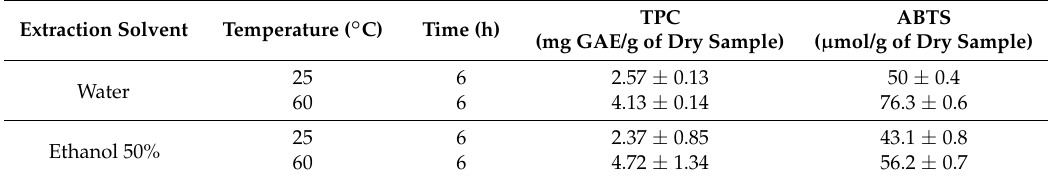
Table 1. Direct comparison of using water and ethanol 50% at different temperature in a continuous solid-liquid extraction in terms of TPC and antioxidant activity of the extracted